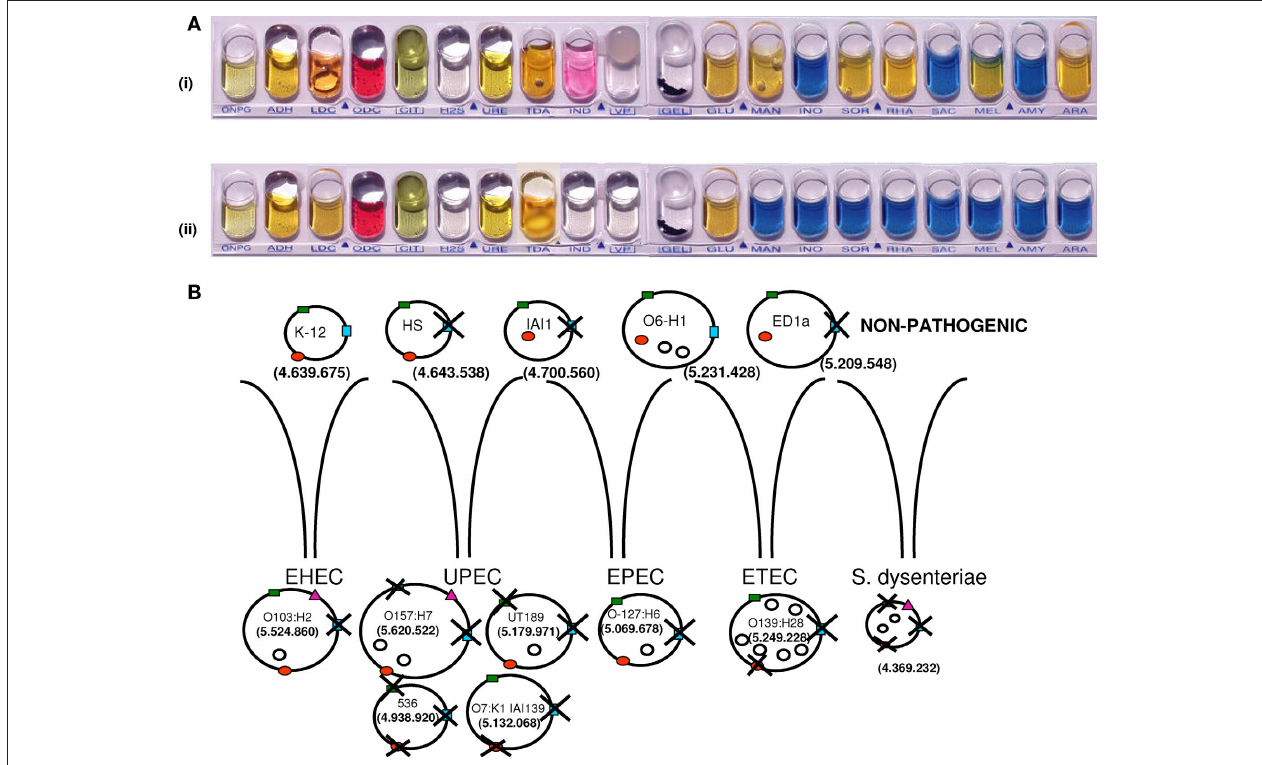
Figure 5 | Shigella dysenteriae and Escherichia coli strains. (A) The metabolic capacity of S. dysenteriae (ii) is limited compared to E. coli (i) . (B) Sequence deletions in non-pathogenic E. coli strains (K-12; O6-H1; ED1a, and HS, IAI1), pathogenic E. coli strains (O103:H2, O157:H7, UT189, 536, O7:K1, O-127:H6, and O1:139:H28), and S. dysenteriae . Pathogenic strains of E. coli are divided into four groups: enterohemorrhagic (EHEC),